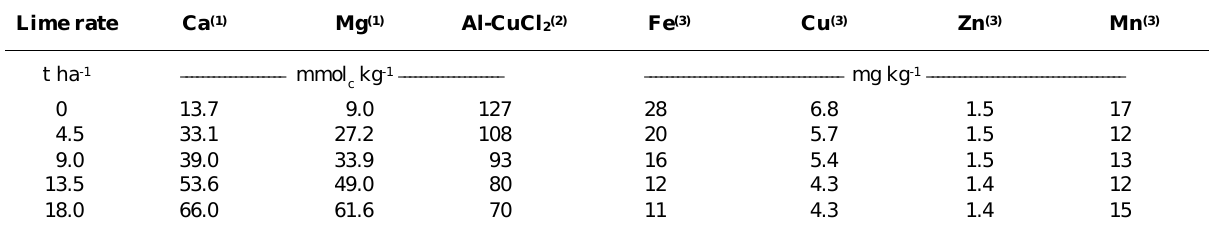
Table 2. Values of Ca, Mg, Al-CuCl 2 , Fe, Cu, Zn, and Mn in soil samples collected in plots with grain corn after the last corn growing season (1995/1996), as affected by addition of increasing rates of dolomitic limestone, in an acid Oxisol, in Lages, Southern Brazil. Average of four replicates